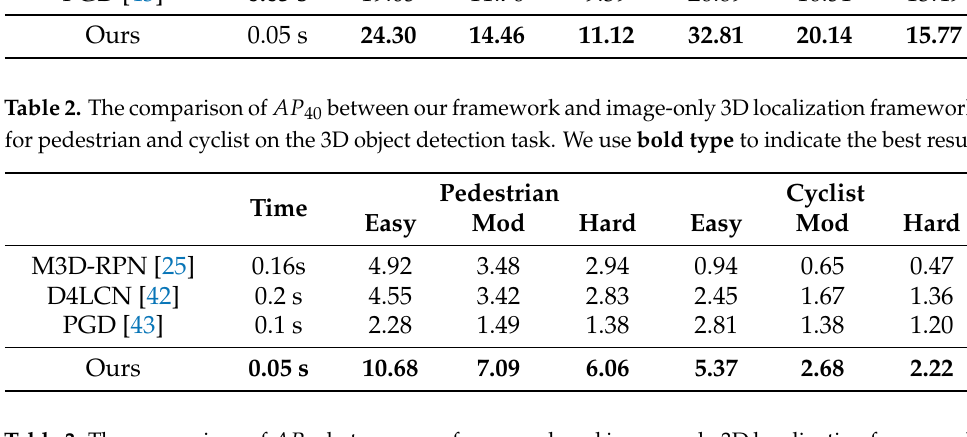
Table 3. The comparison of AP 40 between our framework and image-only 3D localization frameworks that require extra time complexity to generate additional information for car on the Bird’s Eye View object detection task and 3D object detection